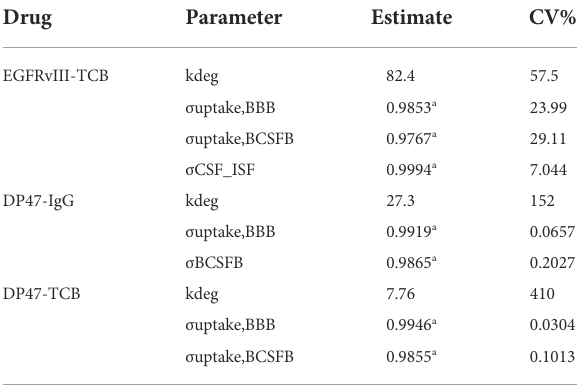
TABLE 3 Results of model parameter estimation.